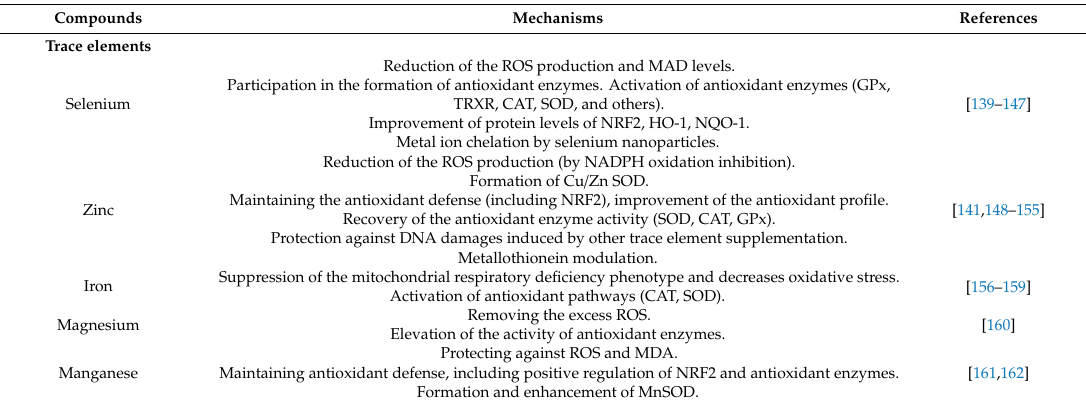
Table 1. Compounds preventing DNA damages due to the stimulation of antioxidant and detoxification systems and transition metal